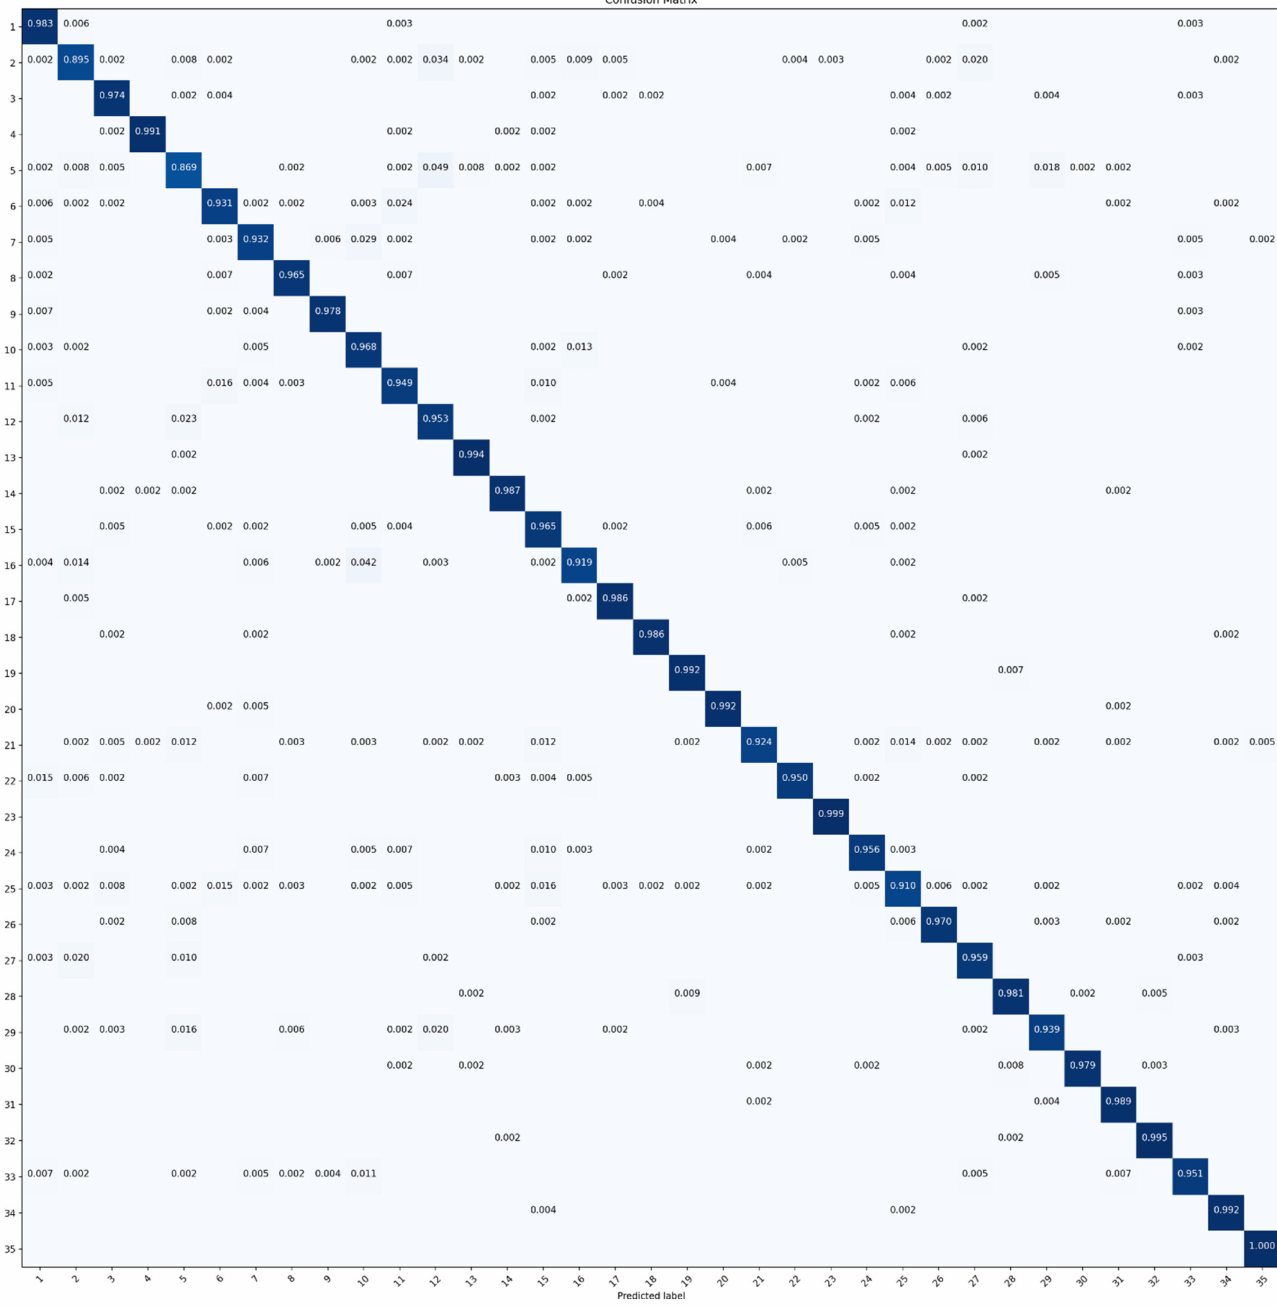
Figure 10. CM of MGCNN-A4 experimentally obtained with the RSI-CB